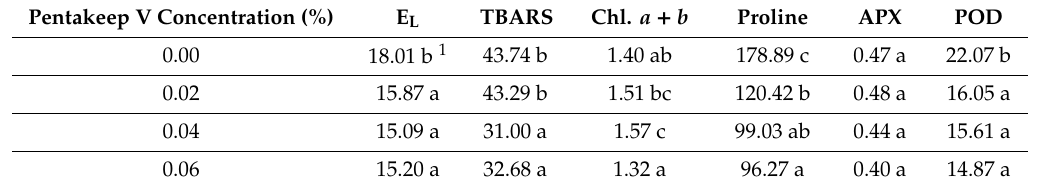
Table 3. E ff ect of Pentakeep V concentration (0.00%, 0.02%, 0.04%, 0.06%) on the mean values (comparative from days 1, 17, and 30) of parameters (electrolyte leakage, thiobarbituric acid reactive substances, chlorophyll a + b , proline, ascorbate peroxidase, guaiacol peroxidase) in P. multiflorum leaves. The averages in the table result from a three-factor statistical